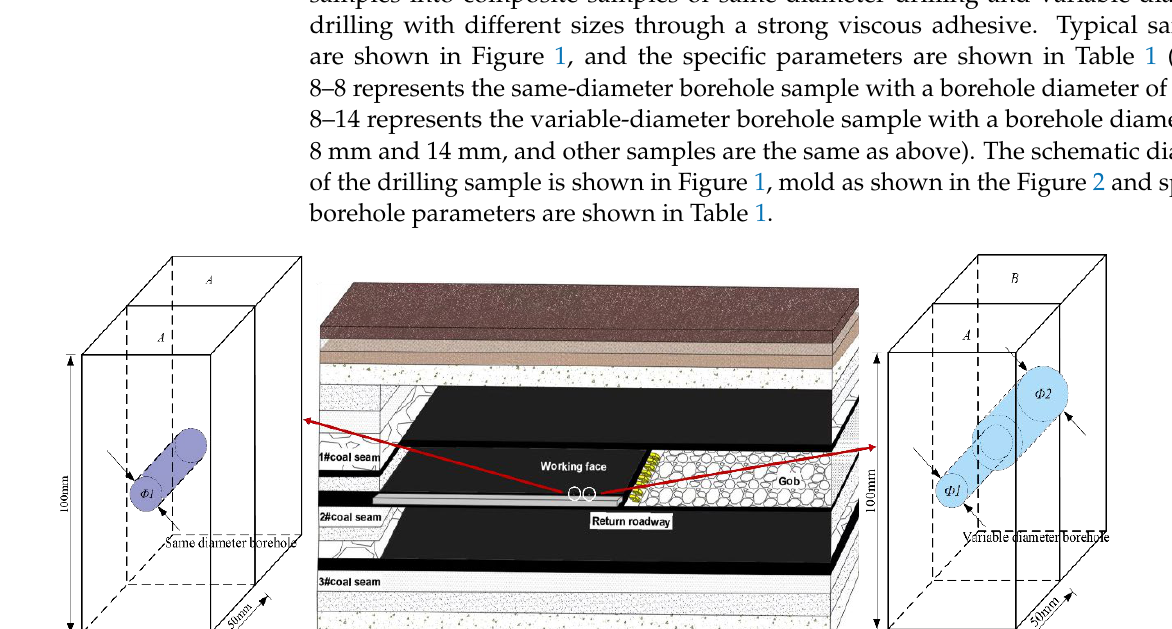
Table 1. Experimental design.